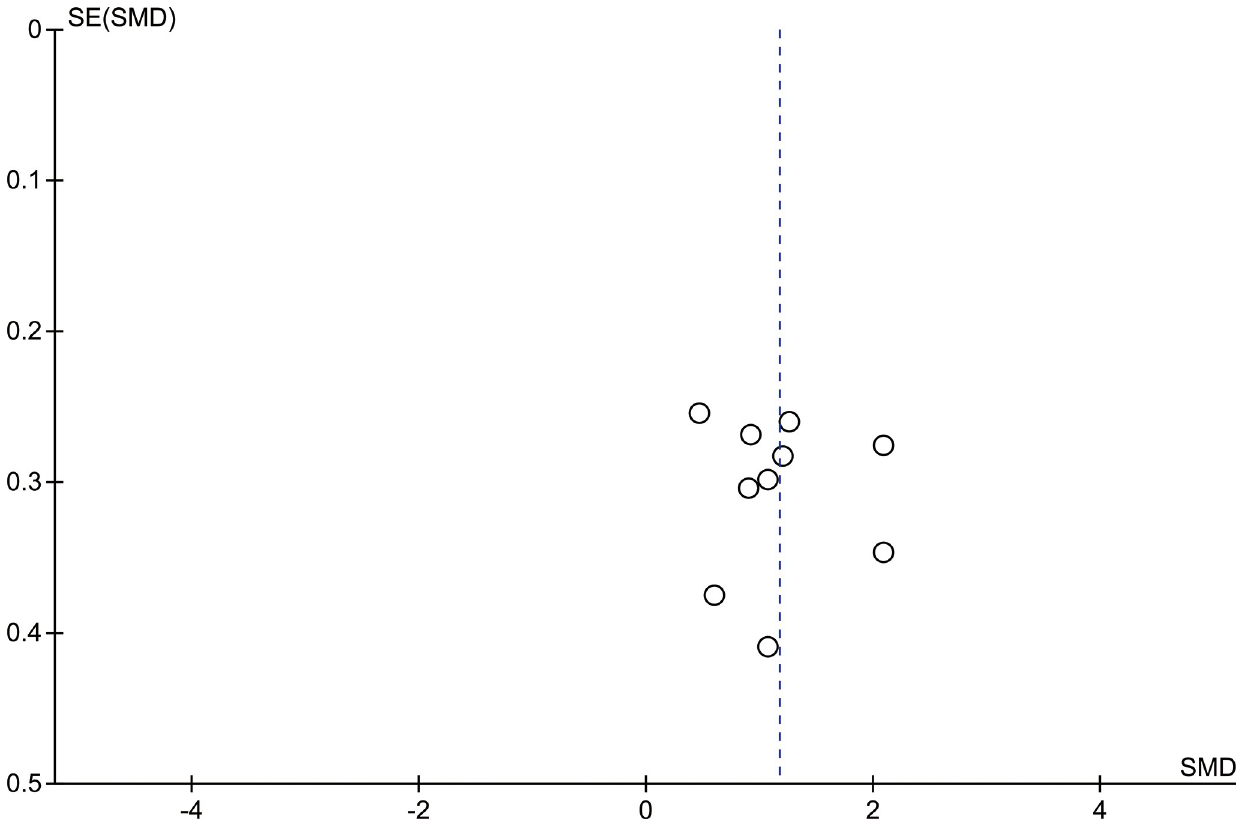
Fig 8. Funnel plot of general cognitive function